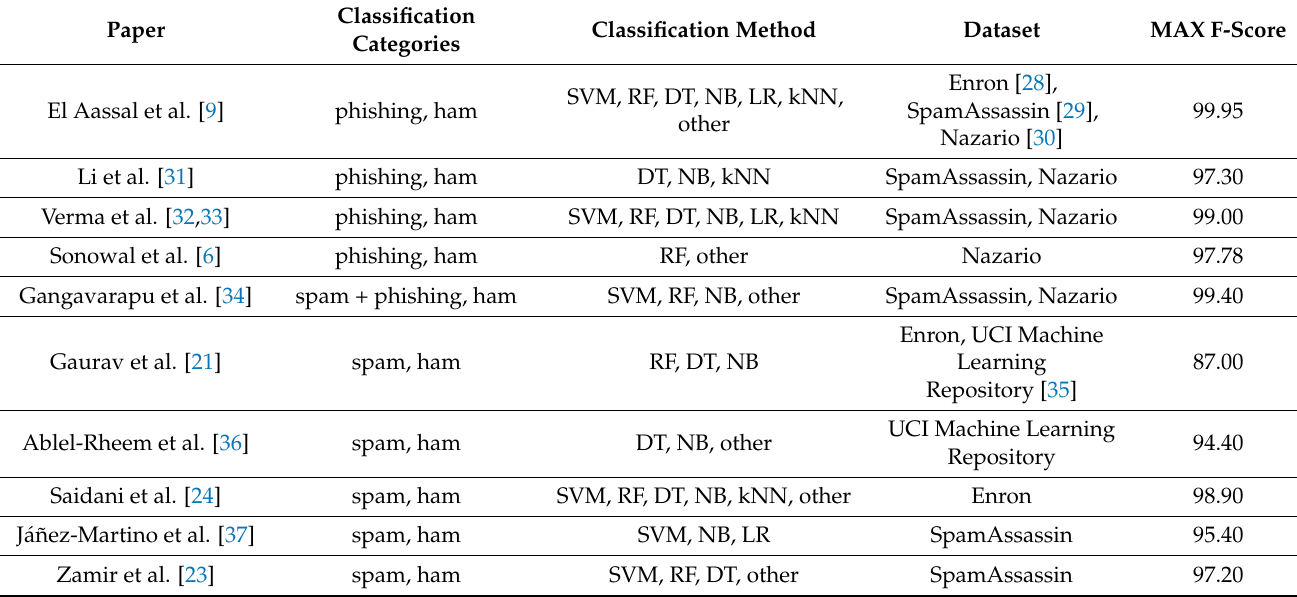
Table 1. Summary of recent papers on machine learning email classification